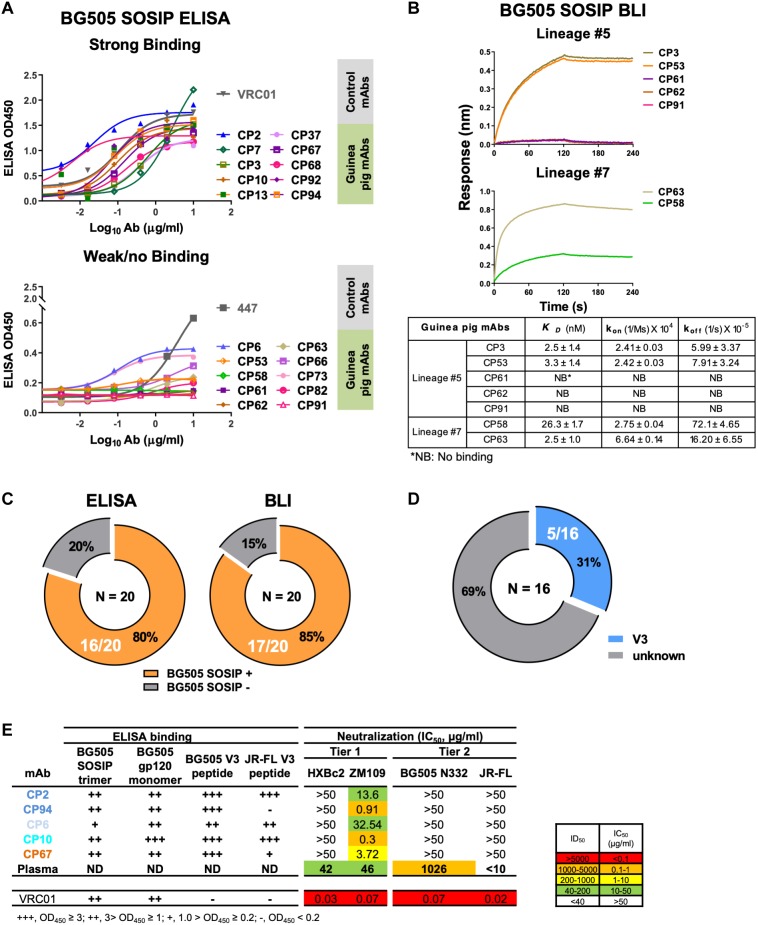
Binding specificity and neutralization profile of guinea pig mAbs isolated from PBMCs. (A) Reactivity of guinea pig mAbs to BG505 SOSIP trimer by ELISA assay. Strong binding (OD450 >0.5); weak/no binding (weak-binding, 0.2<OD450 <0.5; no binding, OD450 <0.2). Data were duplicated, with the mean of OD450 shown. (B) Reactivity of selected guinea pig mAbs to BG505 SOSIP trimer by BLI assay. (Upper) BLI binding curves of mAbs from clonal lineages #5 and #7. mAbs were captured by anti-human IgG Fc biosensors, followed by interaction with BG505 SOSIP trimer in twofold dilution series starting from 1000 to 250 nM, with the curves of 1000 nM shown. (Lower) mAb-BG505 SOSIP trimer binding kinetic parameters, shown as measured value ± standard error. kon, on-rate or association rate; koff, off-rate or dissociation rate; KD, binding affinity constants (dissociation constant), determined as koff/kon. (C) Summary of BG505 SOSIP trimer reactivity by ELISA and BLI. Of 20 mAbs expressed (left) 16 (80%) and (right) 17 (85%) show detectable binding activity to BG505 SOSIP trimers by ELISA and BLI assay, respectively. (D) Pie chart showing the binding specificity of the 16 BG505 SOSIP-reactive mAbs isolated from guinea pig 1567 by ELISA assay. V3-reactivity was assessed by positive reactivity (OD450 >0.2) with peptides derived from V3 regions of HIV isolates BG505 or JR-FL. (E) Neutralization potency (IC50, μg/mL) of isolated mAbs against Env-pseudotyped viruses. mAbs are color-coded to differentiate corresponding clonal lineage. Animal 1567 plasma neutralization titers (ID50) against HXBc2, ZM109, BG505 N332 (autologous virus corresponding to the immunogen, BG505 SOSIP, which contains N332 glycan), and JR-FL pseudoviruses were shown for comparison. ID50 are values of the plasma reciprocal dilution factors at which 50% inhibition of infection are achieved in the assay. The background neutralization ID50 titer threshold is set as <10. ND, not determined. ELISA binding to BG505 SOSIP trimer, BG505 gp120 monomer, BG505 V3 and JR-FL V3 peptide are also shown. Broadly neutralizing mAb, VRC01 (CD4bs epitope specific) is shown as control. Data are duplicated with the mean of IC50/ID50 shown.